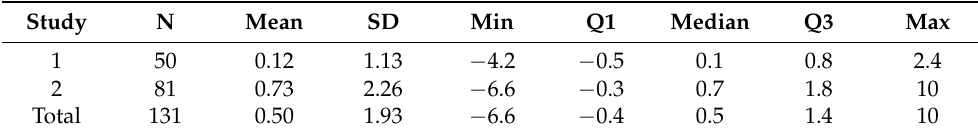
Table 1. Descriptive statistics for differences in lymphedema hindlimb measurements between the two raters by study and